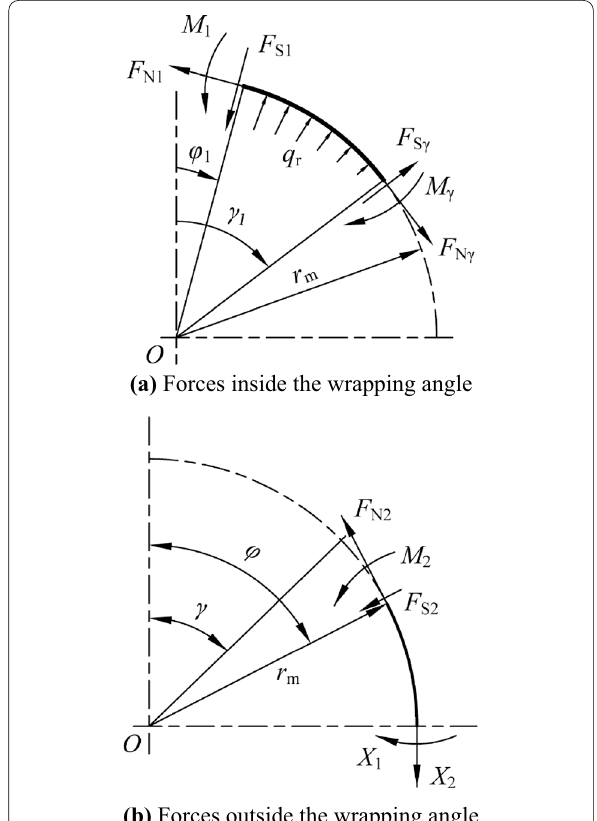
(b) Forces outside the wrapping angle Figure 3 Free body diagram of the